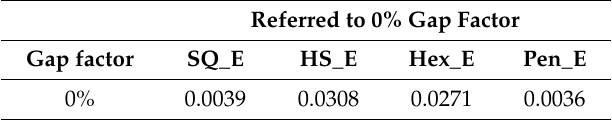
Table 3. The correlation between the results of HoG for SQ images and the other four types of images in respect to block size.